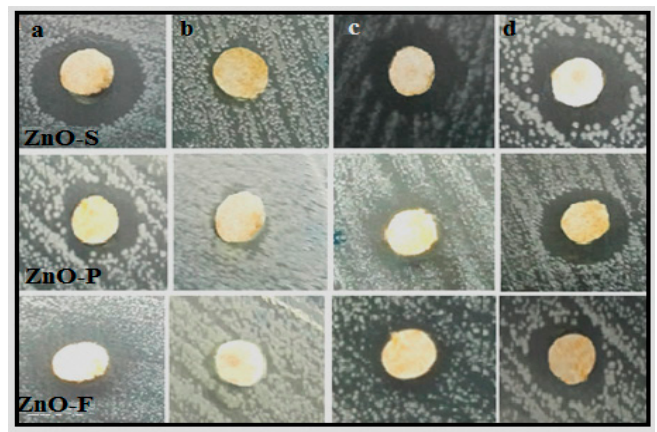
Figure 9. Inhibition zone of synthesized ZnO-NPs against ( a ) B. subtilis ; ( b ) MRSA ; ( c ) P. aeruginosa and ( d ) E. coli pathogens.